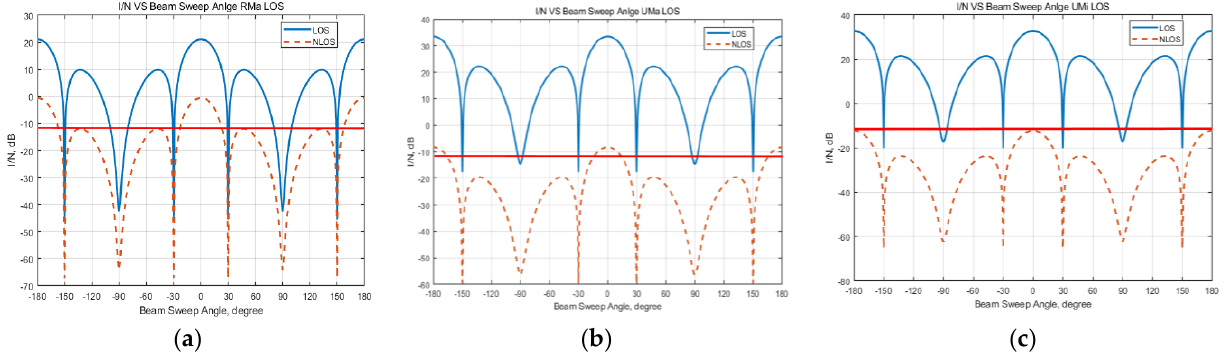
Figure 4. Interference/noise (I/N) from the base station (BS) to the Earth station (ES) for a distance of 15 km with a 4 × 4 antenna array. ( a ) Rural macrocell; ( b ) urban macrocell; ( c ) urban microcell.